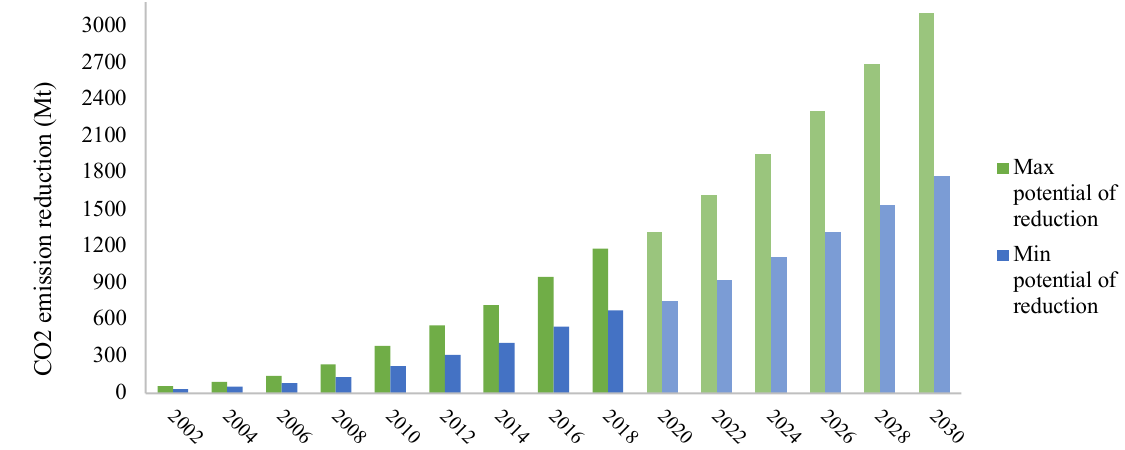
Figure 4. CO emissions mitigation potential of wind energy resources in the world 2